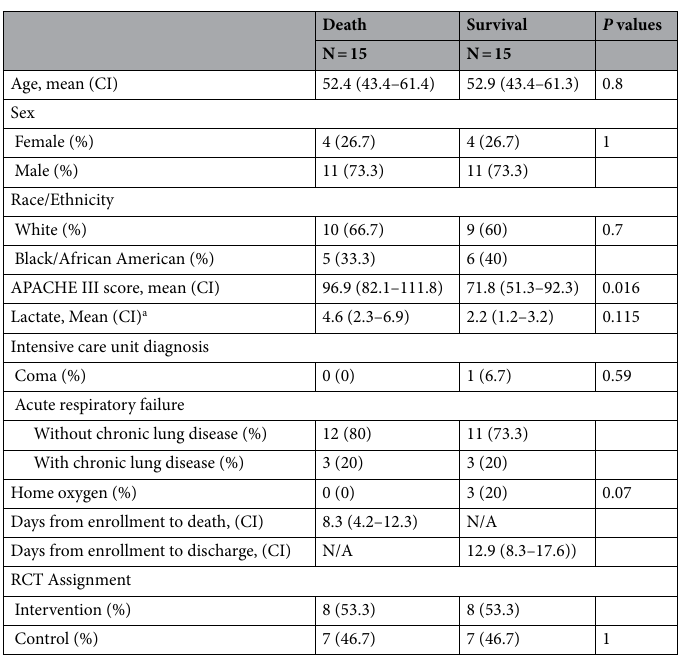
Table 1. Patient demographics. CI 95% confidence interval. a Survivor n = 9; nonsurvivor n =